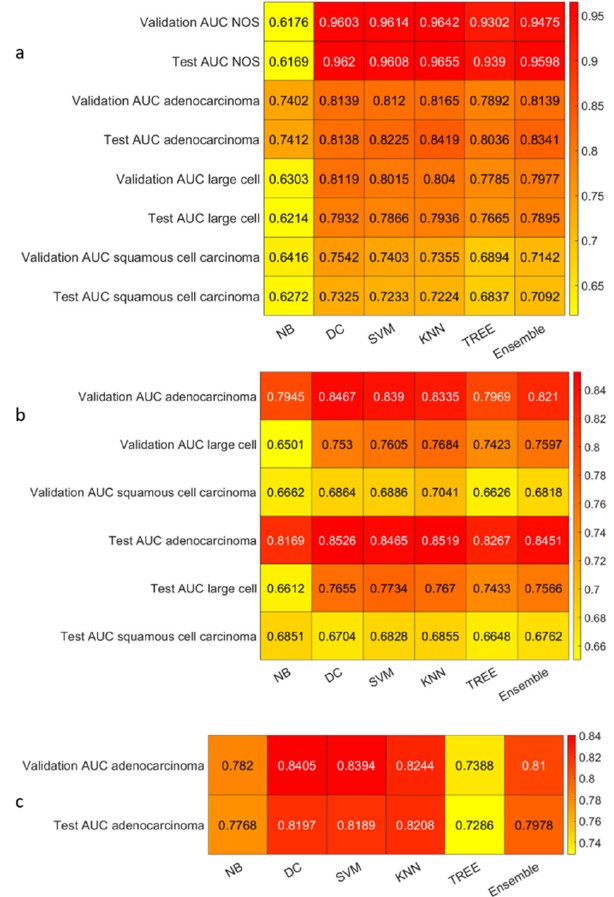
Figure 11. AUC heatmaps: ( a ) The 4-classes datasets, ( b ) 3-classes datasets, and ( c ) 2-classes datasets.